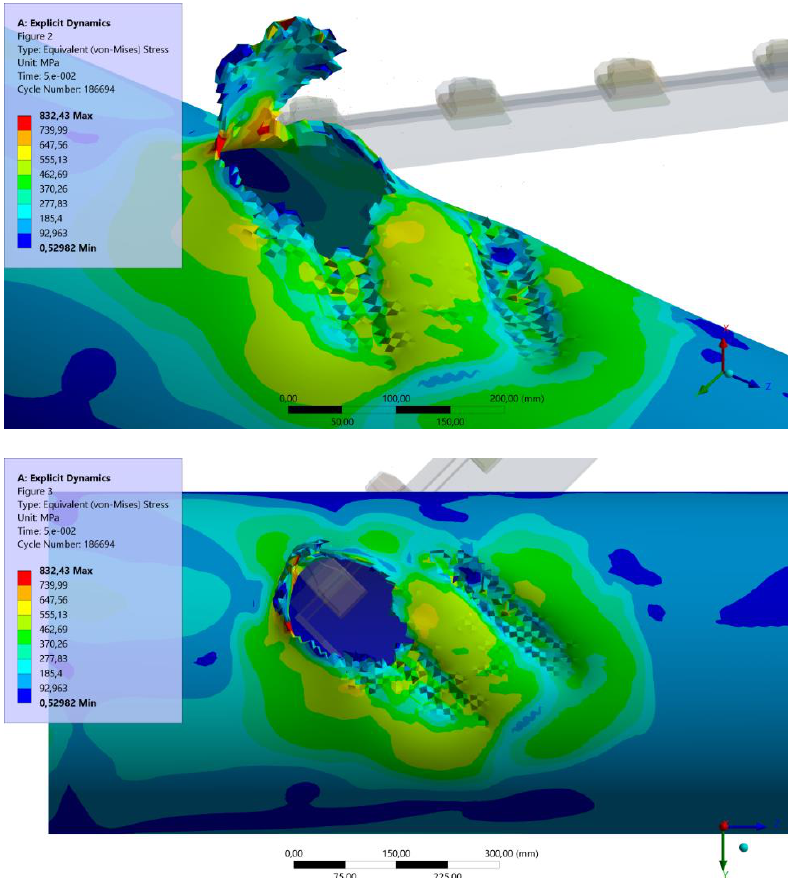
Figure 14. Development of the pipeline destruction at the bucket position according to Variant 3.